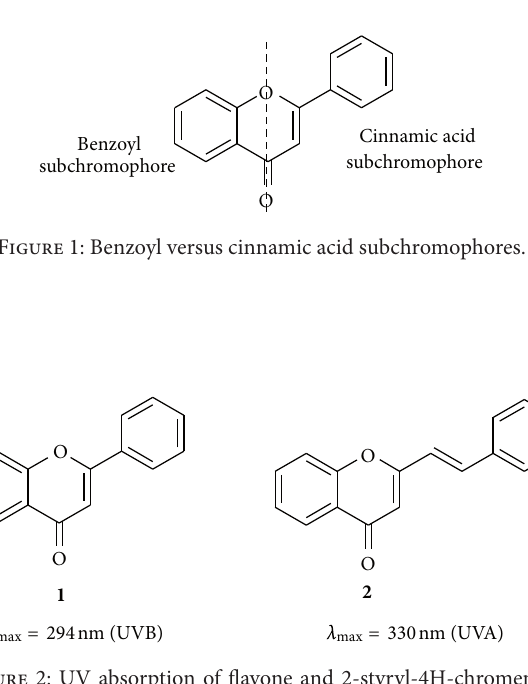
F 2: UV absorption of �avone and 2-styryl-4H-chromen-4-